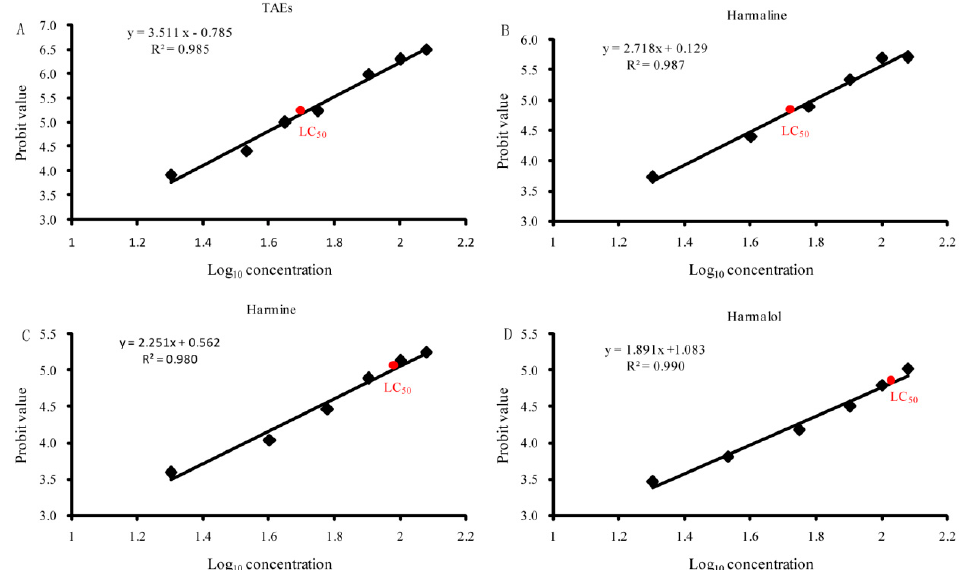
Figure 3. Evaluation of the median lethal concentration (LC 50 ) of the tested alkaloids against third ‐ instar larvae. Linear regression analysis of the log value of alkaloid concentrations and probit value of larval mortalities at 48 h post-treatment. ( A ) TAEs, ( B ) harmaline, ( C ) harmine, and ( D ) harmalol, with the LC 50 values of 44.54 ± 2.56, 55.51 ± 3.01, 93.67 ± 4.53, and 117.87 ± 5.61 µ g/mL, respectively. The LC 50 value was calculated from the average of three replicates.